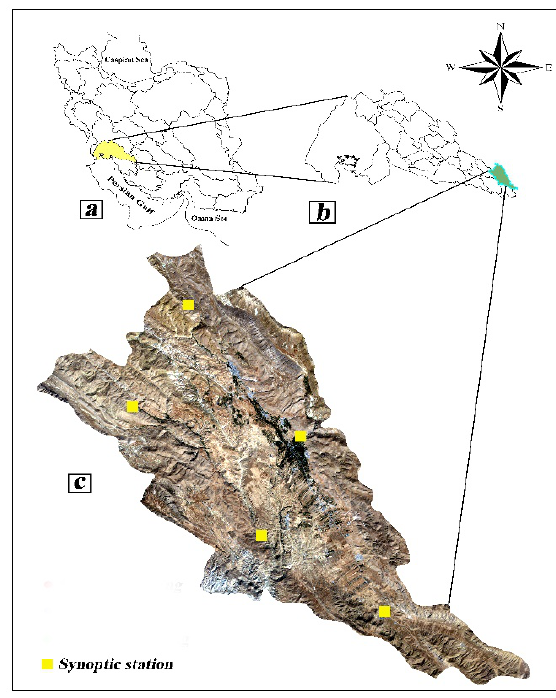
Fig. 1 a: Location of the Jarahi-Zohre catchment on the map of Iran’s water basins, b: Location of Sheshpeer sub-catchment on Jarahi-Zohre divisions and c: Sheshpeer sub-catchment (RGB true color composite OLI image) The tectonized carbonate formations have the potential for landslide due to the presence of fractures and joint systems, and there are several sinkholes in the high altitude areas of Barmfiruz mount which concentrate the surface runoff or snow melting water into the ground layer.